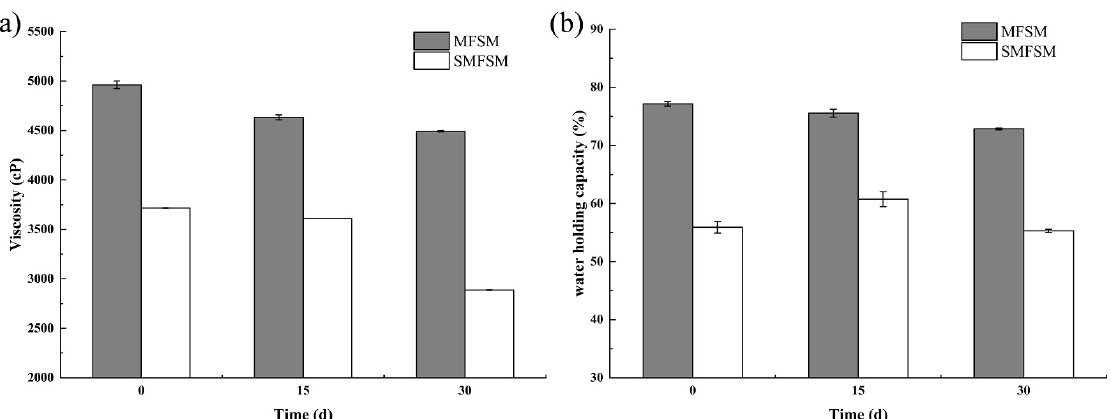
Figure 3. Effect of two mixed fermentation methods on the viscosity and water-holding capacity of fermented soymilk and milk mixtures during storage: ( a ) the change in viscosity during storage and ( b ) shows the change in water-holding capacity during